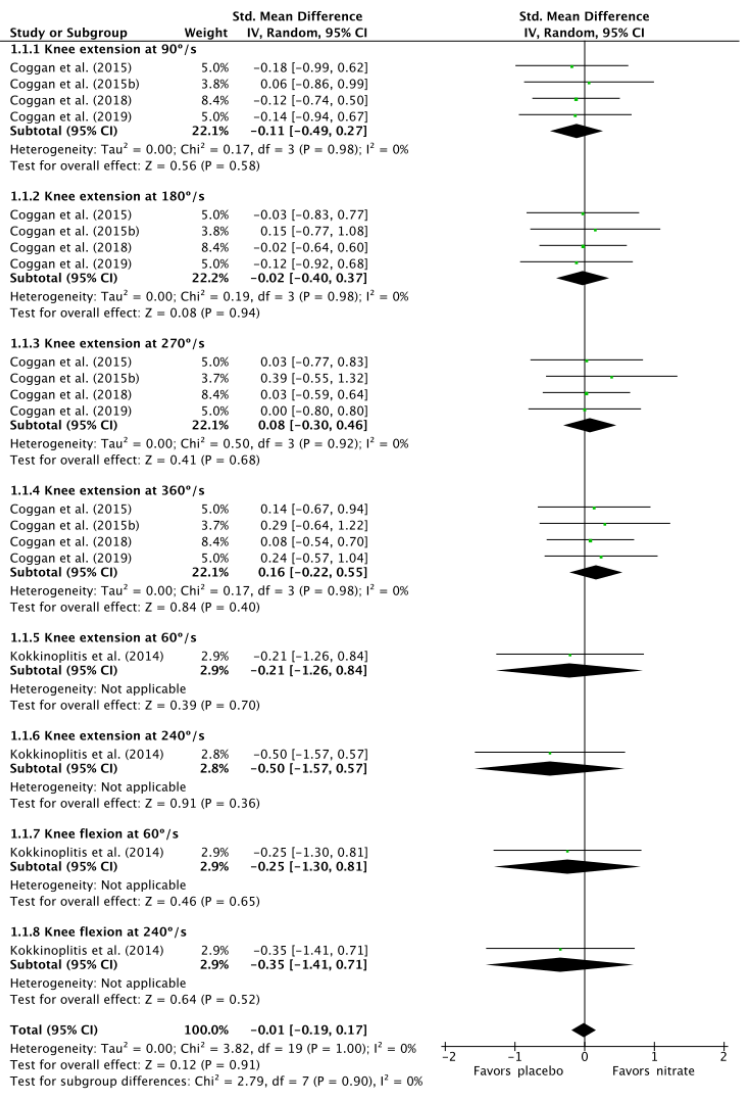
Figure 2. Forest plot comparing the effects of placebo and nitrate (NO 3 − ) supplementation on isokinetic torque production. The size of the plotted squares reflects the statistical weight of the study. Horizontal lines denote the 95% confidence intervals.